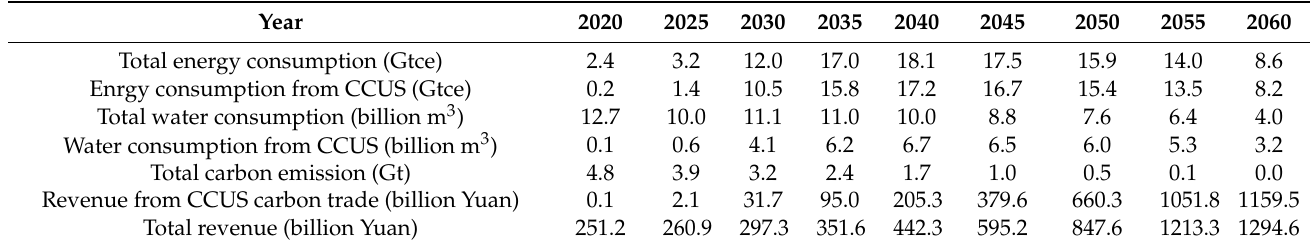
Table 19. ATPCC outputs of “Radical” portfolio for China’s coal power